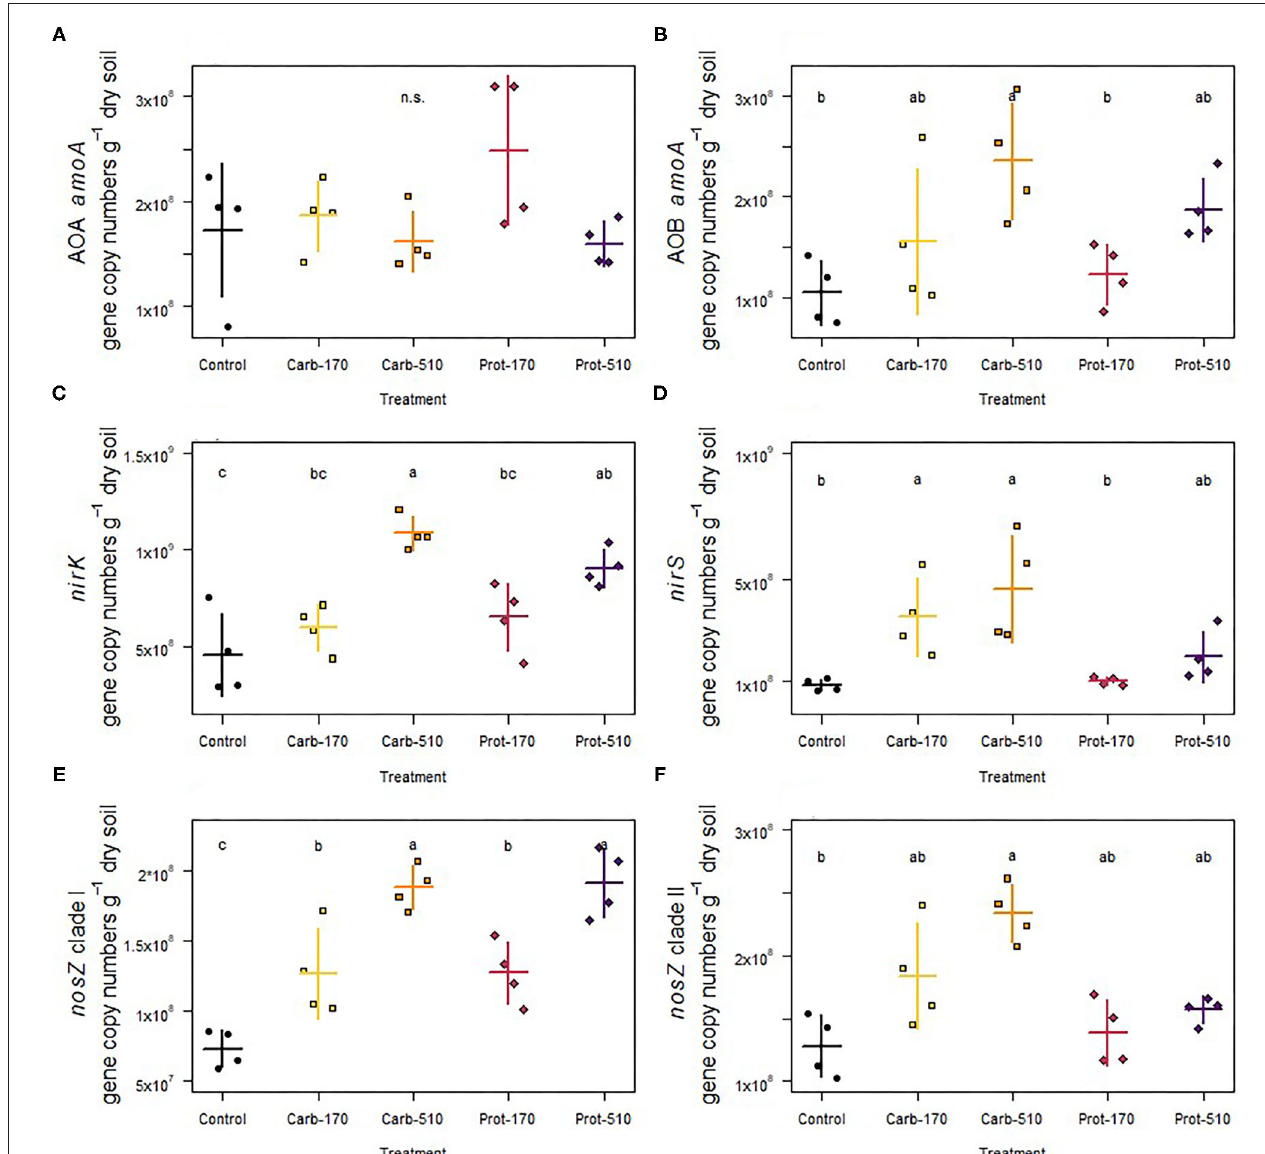
FIGURE 6 | (A,B) Abundance of functional genes involved in ammonia oxidation, (C,D) nitrite reduction, and (E,F) nitrous oxide reduction. Means ± standard deviation ( n = 4) and letters indicating significant differences (for statistical data see Supplementary Table 2 ) are shown.